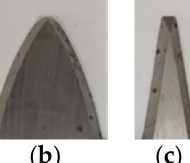
Figure 7. Metal ordinary blade and bionic blade: ( a ) ordinary blade; ( b ) bionic blade e ; and ( c ) bionic blade f .